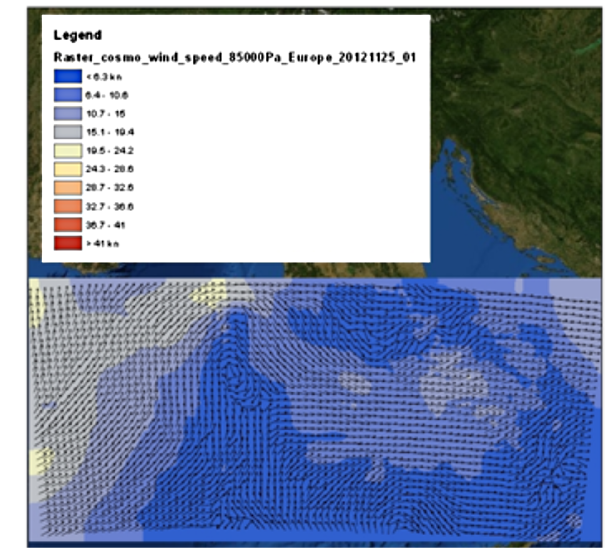
Figure 8. Forecast of wind speeds and directions of 25 Novem- ber 2012 at 01:00UTC.